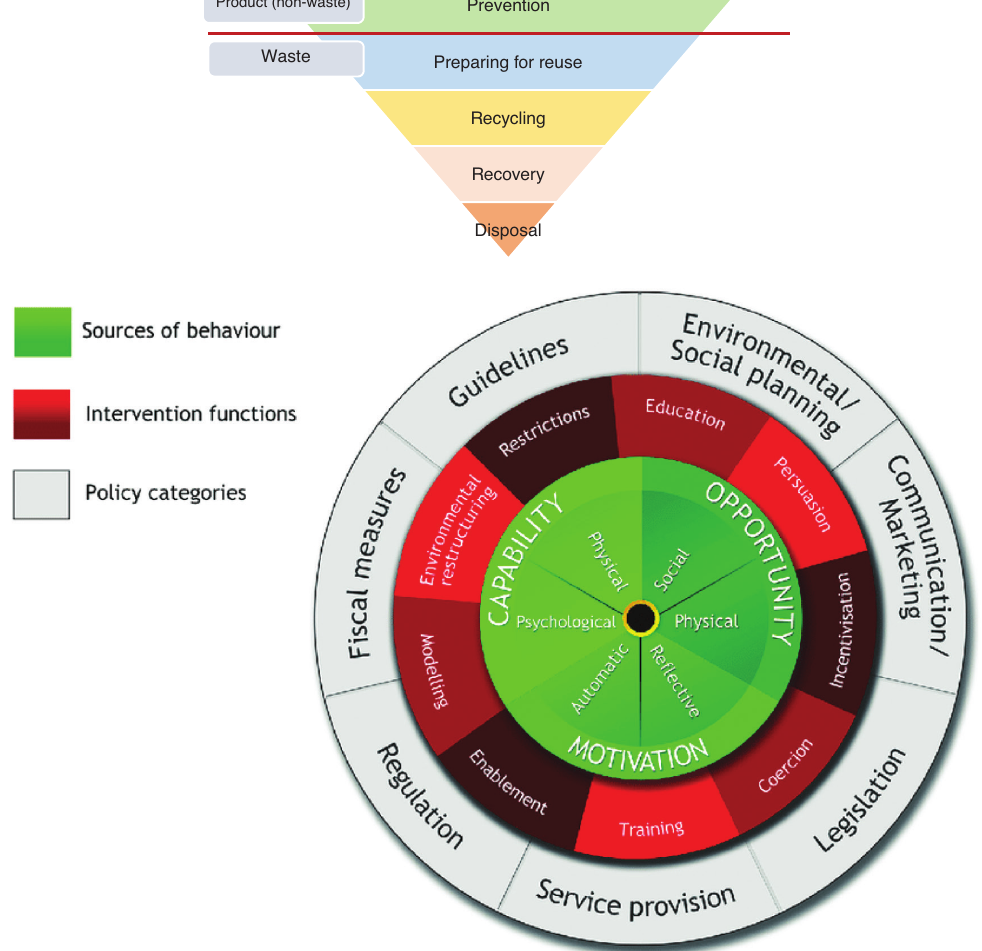
The Waste Hierarchy as set out in Article 4 of the revised Waste Framework (Directive 2008/98/EC).